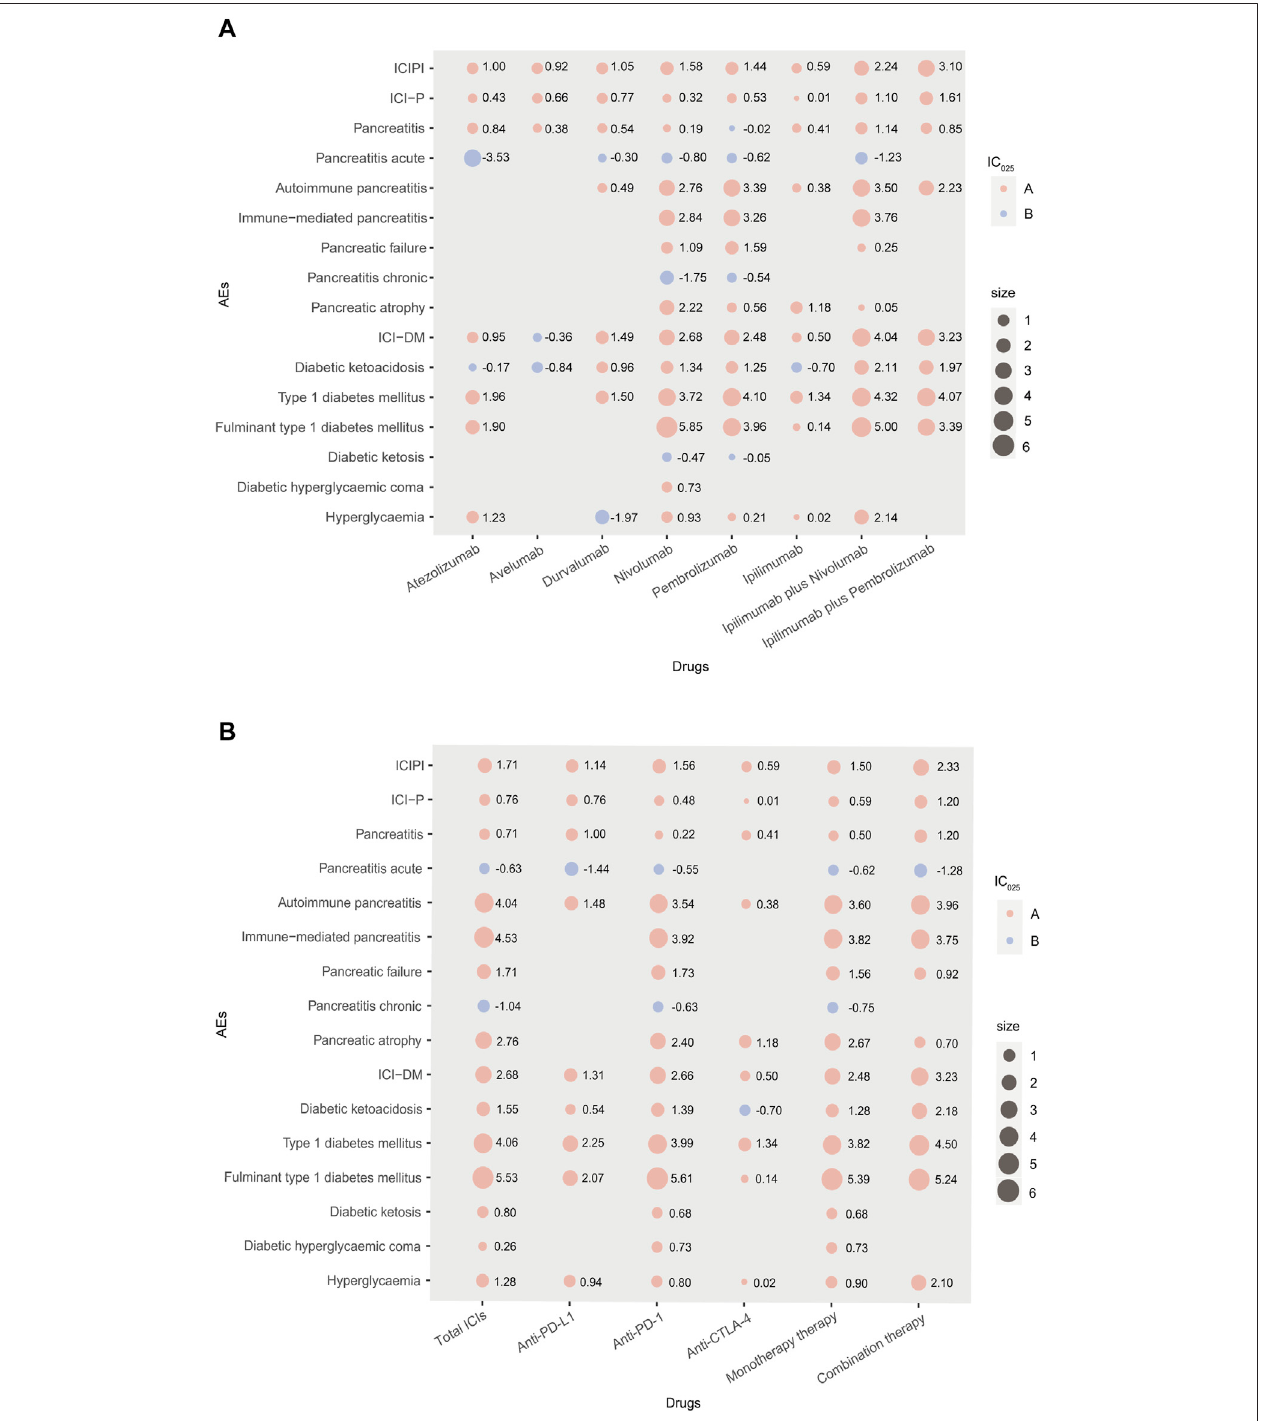
FIGURE 1 | (A,B) Pancreatic AEs signals pro fi les of different ICIs strategies with all drugs as comparator. In Panel 1, AEs: adverse events; IC: information component; IC 025 : the lower end of the 95% con fi dence interval of IC; A: IC 025 > 0; B: IC 025 < 0; size: absolute value of IC 025 ; ICI-P: ICI-associated pancreatitis; ICI-DM: ICI-associated diabetes mellitus; combination therapy: nivolumab plus ipilimumab, pembrolizumab plus ipilimumab.